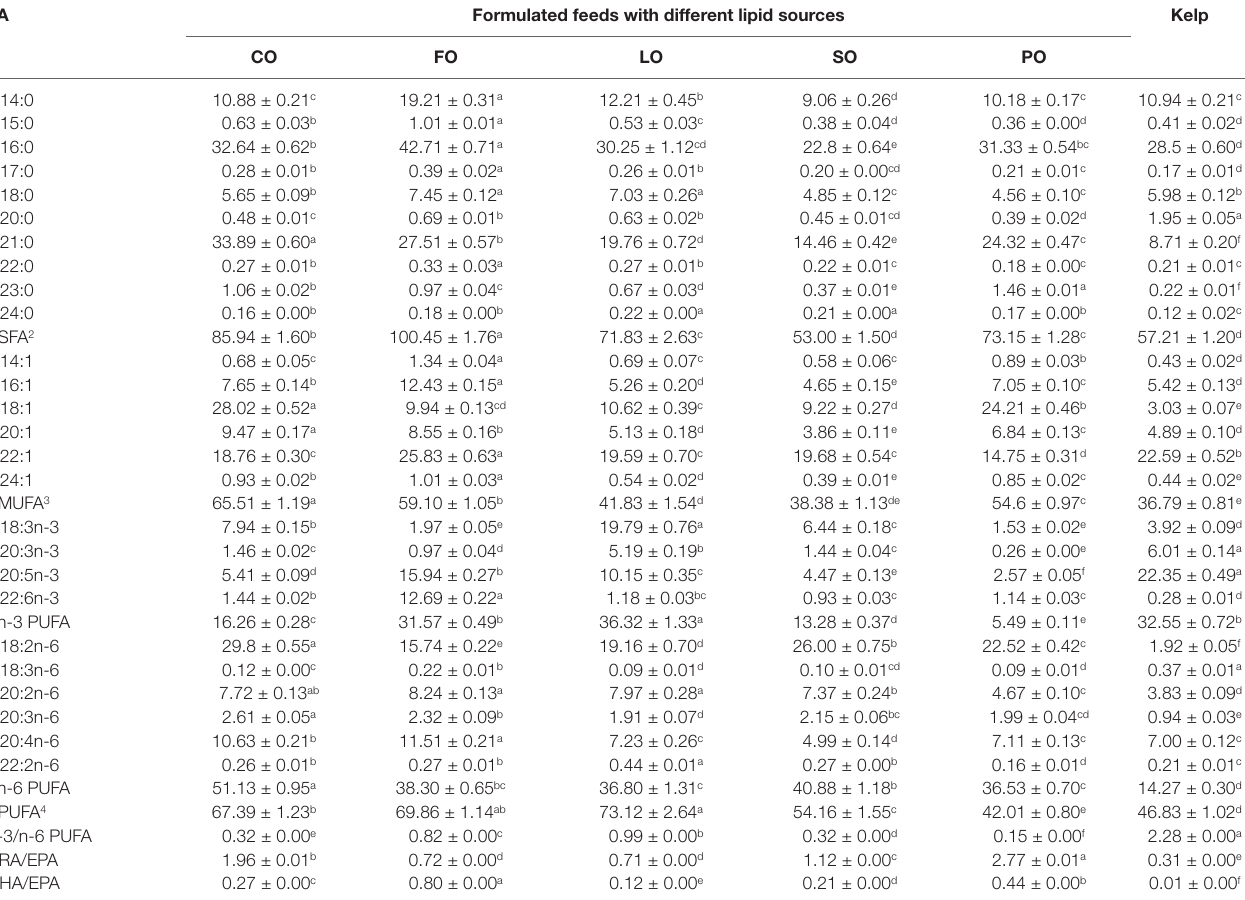
TABLE 9 | Effects of different lipid sources on the fatty acid composition (g/kg dry matter) of eggs of adult sea urchin ( Strongylocentrotus intermedius ) (mean ± SEM, n=3) 1 . FA Formulated feeds with different lipid sources Kelp CO FO LO SO